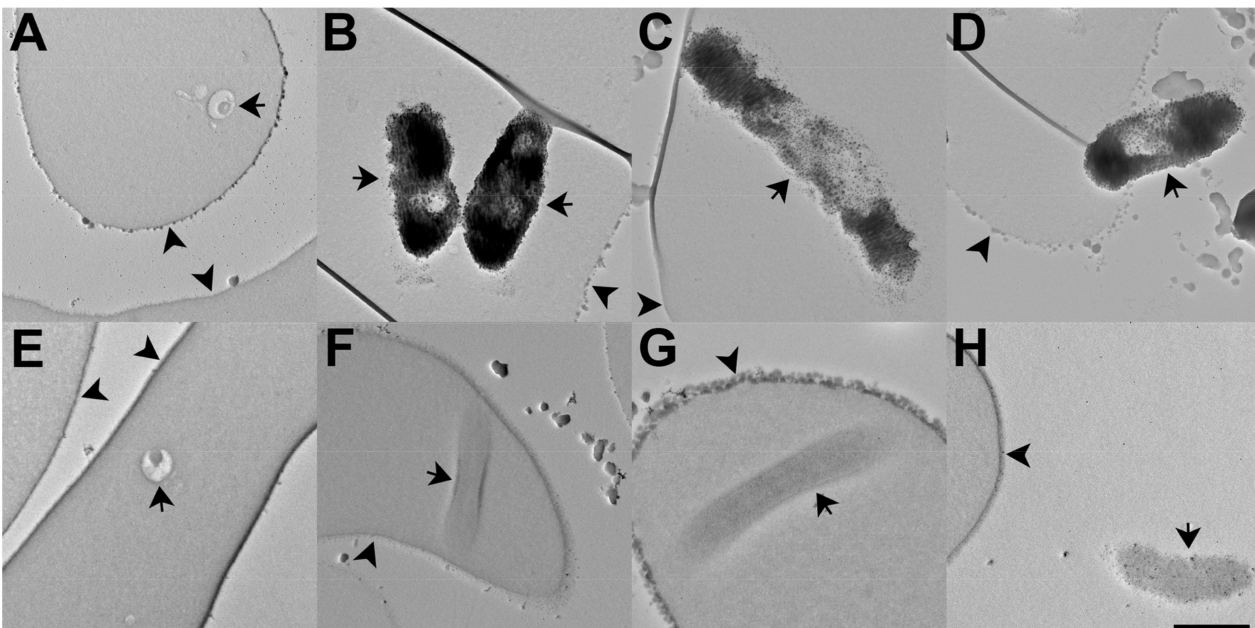
Figure 6. Transmission electron micrographs of pRBCs treated with Calxinin. Treatment of 500 nM Calxinin leads to a profound decrease in intracellular Ca 2+ concentration in Pf trophozoites, schizonts, and ring stage. ( A – D ) Representative electron micrographs of DMSO-treated Pf in the ring, early trophozoite, late trophozoite, and schizont stages, respectively. Arrowheads point to the RBC plasma membrane. Arrows point to Pf . ( E – H ) Representative electron micrographs of Calxinin-treated Pf